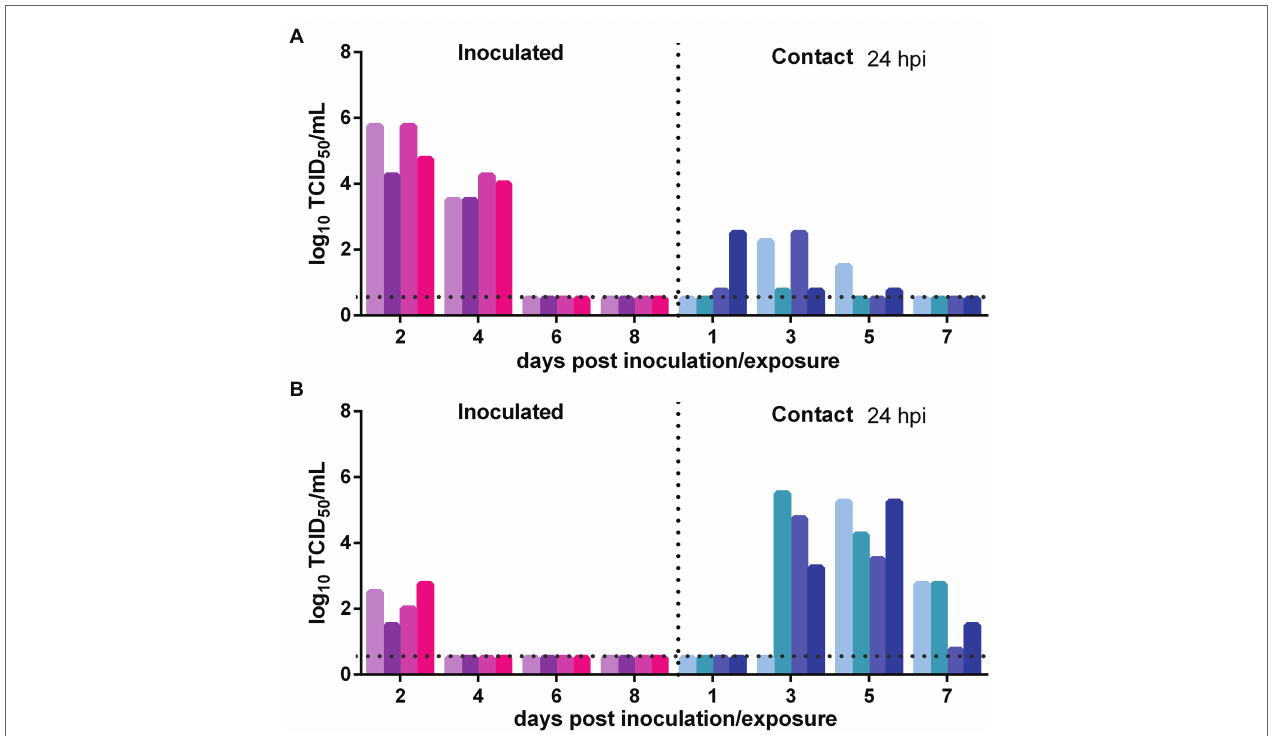
FIGURE 5 | Impact of a lower inoculation dose on SARS-CoV-2 transmission between naïve Syrian hamsters and previously infected Syrian hamsters at 24 hpi with 10 4 TCID 50 of SARS-CoV-2. The dotted line represents the detection limit of the viral titer and colored bars are indicating individual animals. The time between infection and start of the transmission experiment was showed on the upper right side. (A) Viral titers detected in the nasal washes of the initially infected donors inoculated with SARS- CoV-2 and the previously infected contacts. (B) Viral titers detected in the nasal washes of previously infected donors inoculated with SARS-CoV-2 and the naïve